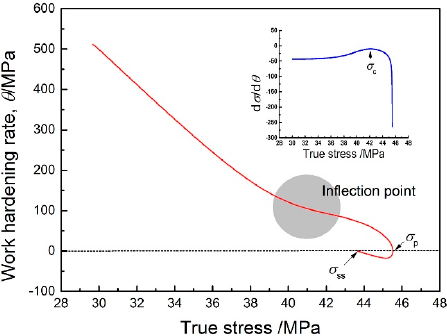
Figure 8. An example for identifying the values of σ ss and σ c through plotting θ vs. σ and d θ / d σ vs. σ (1373 K/0.01 s − 1 ).